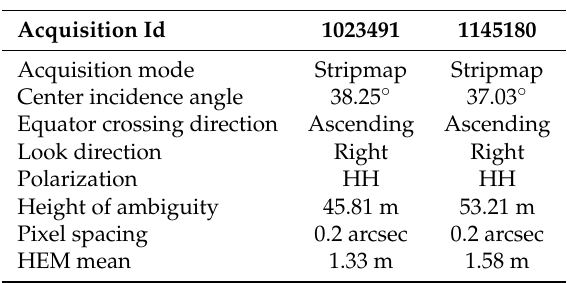
Table 2. Properties of the nominal TanDEM-X raw digital elevation models (DEMs) tiles for the Munich